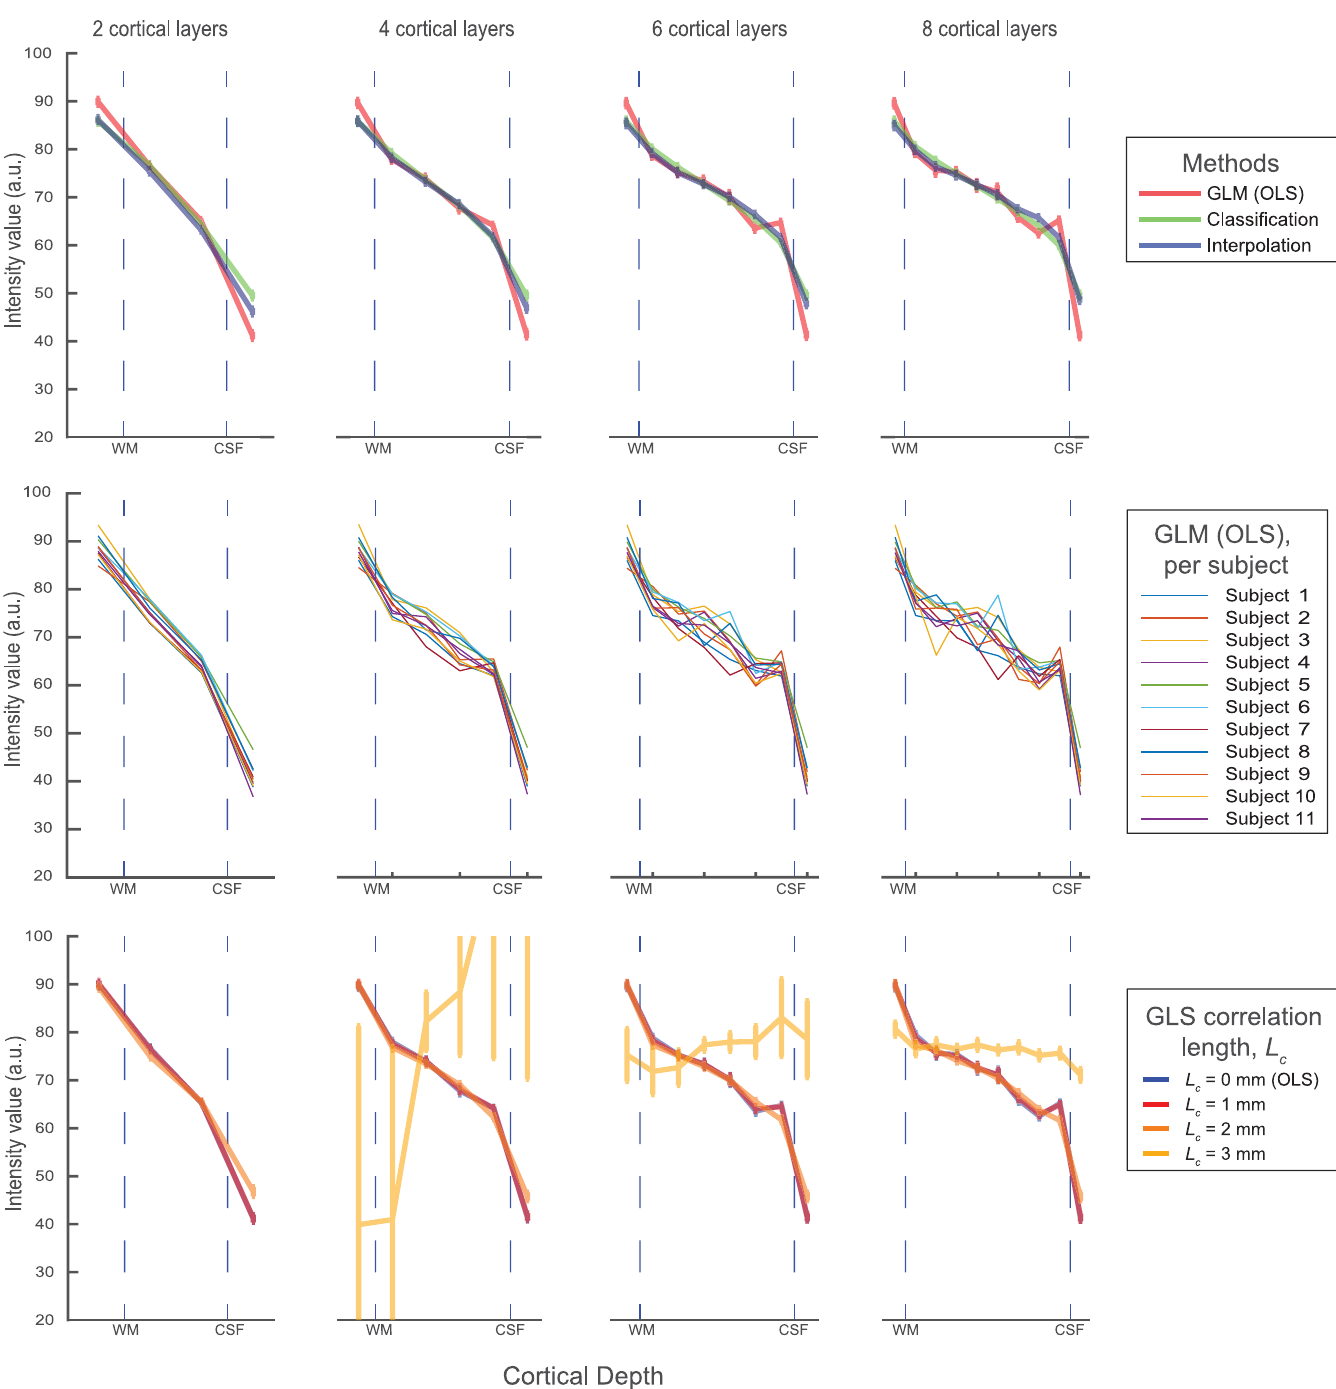
Fig 7. The obtained profiles for a small piece of the primary visual cortex, based on 11 subjects, for a varying number of layers (columns). In the first row, the three different methods are compared. The second row shows the individual profiles for the GLM method, showing that the solution becomes unstable when higher numbers of layers are used. In the bottom row, different correlation lenghts are tested in a generalised least squares solution.